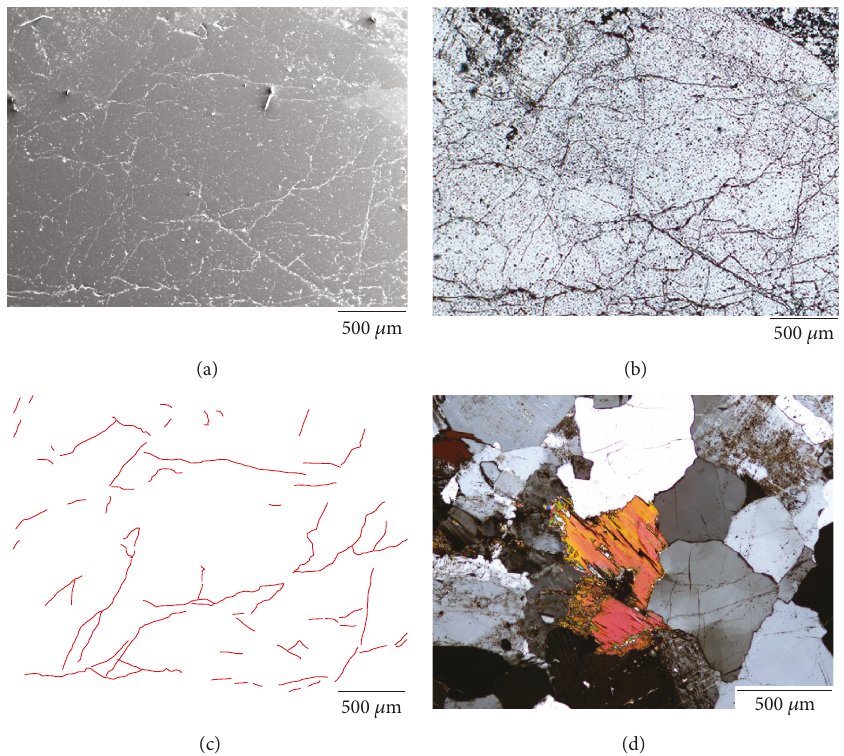
Figure 9: SEM image and photomicrographs of microfractures in the granite. (a) SEM image of developed open microfractures without fi lling minerals of the borehole DH-13 553.8. (b) Photomicrograph (thin section, open nicol) and (c) traced lines of these open microfractures. (d) Photomicrographs of fewer microfractures and second growth of the relict biotite of the borehole DH-11 537.2 (thin section, cross